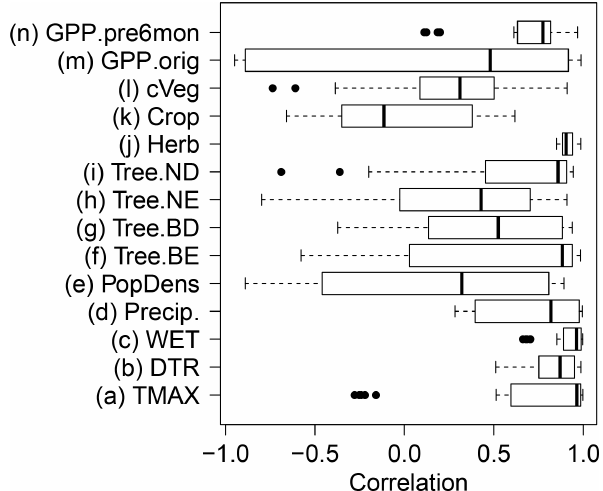
Figure 5. Correlations between global relationships from satellite- derived and model-derived RF “fm” experiments. Pearson corre- lations were computed from the relationships as shown in Fig. 4. Boxes show the distribution of all model–data correlations (five satellite-derived relationships × seven FireMIP model-derived rela- tionships). Correlations for individual satellite- and model-derived RFs are shown in Fig.